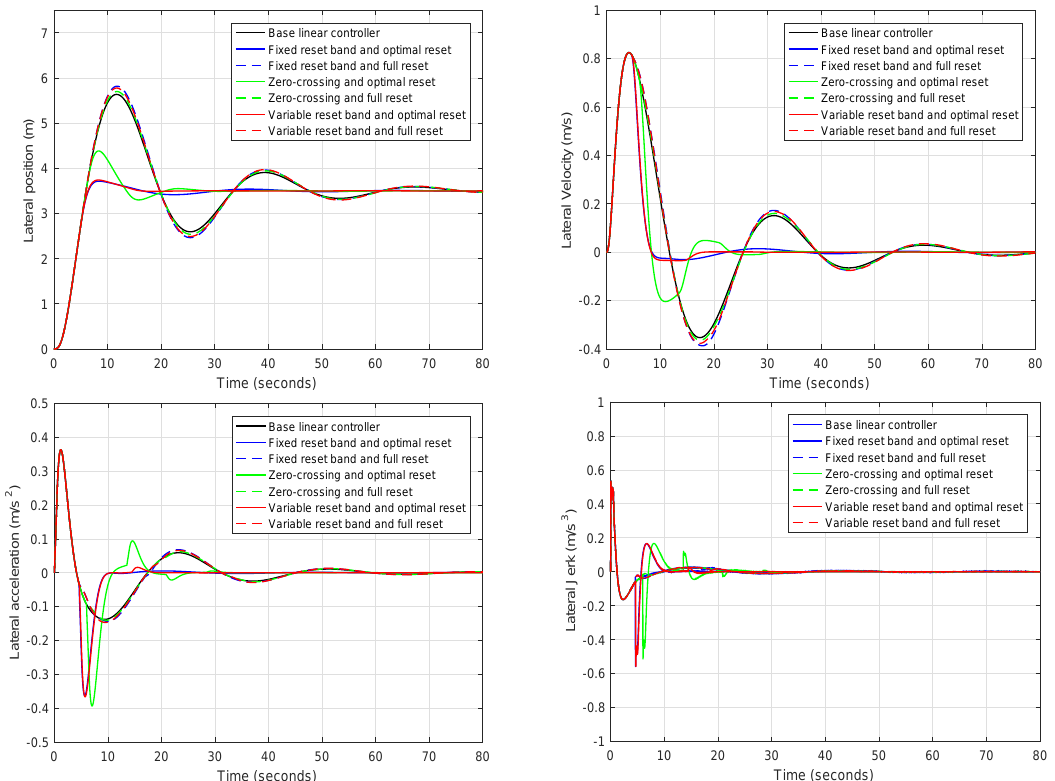
Figure 28. Position, velocity, acceleration and jerk for different reset strategies in